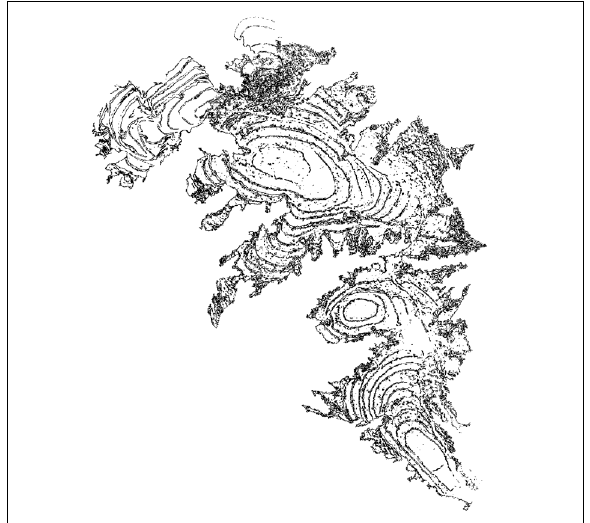
Figure 5a. Normal Vector Segmentation